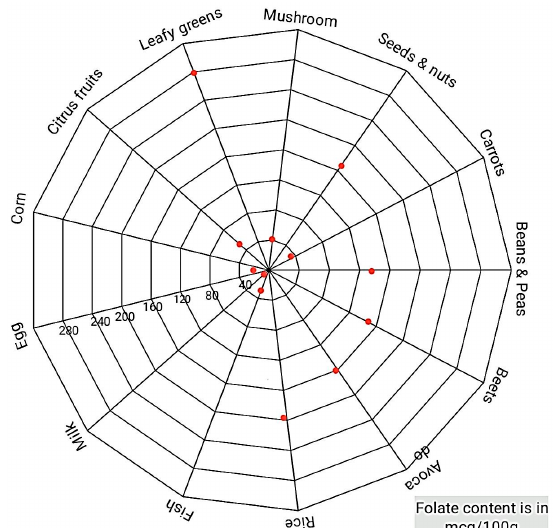
Figure 5. Folate-containing foods, the maximum folate is present in leafy green vegetables, followed by seeds, nuts, and rice; mcg/100 g